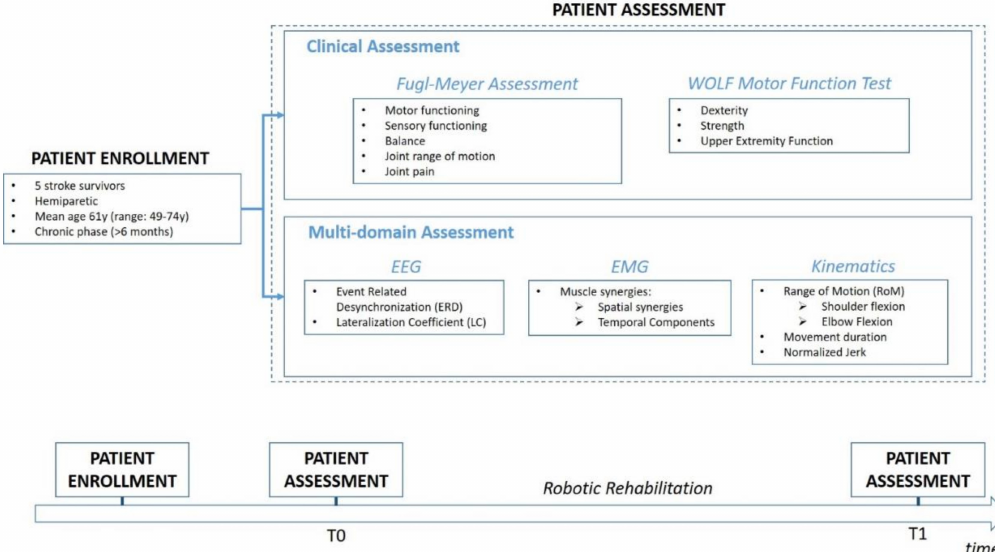
Figure 1. Flow-chart of the study design. Five post-stroke survivors were enrolled in this study (for inclusion criteria and their data see Section 2.1.2). Each patient was administered 1 month of robotic therapy. At T0 (before the therapy) and at T1 (after the therapy), a multidomain assessment that included electroencephalography (EEG) recordings (during passive assisted forearm elbow-flexion), electromyography (EMG), and kinematics recordings (during non-assisted hand-to-mouth movements (HTMM)) was performed. The instrumental evaluations were coupled with standard clinical assessments (Fugl–Meyer Assessment and Wolf Motor Function Test) for a detailed characterization of the effects of the